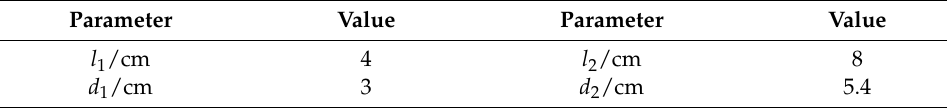
Table 2. Dimensions of coaxial induction